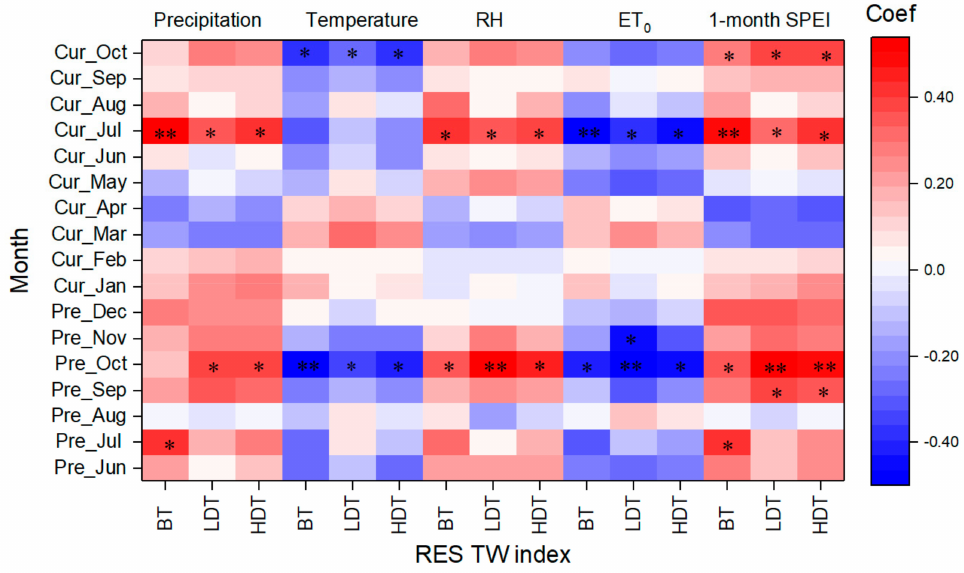
Figure 6. Relationships between the residual (RES) tree-ring index and monthly climatic factors for all of the groups at a monthly timescale. Cur_month represents the current year of ring formation and Pre_month represents the climate variables during the year preceding ring formation. Asterisks * and double asterisks ** indicate significant di ff erences at p < 0.05 and p < 0.01,